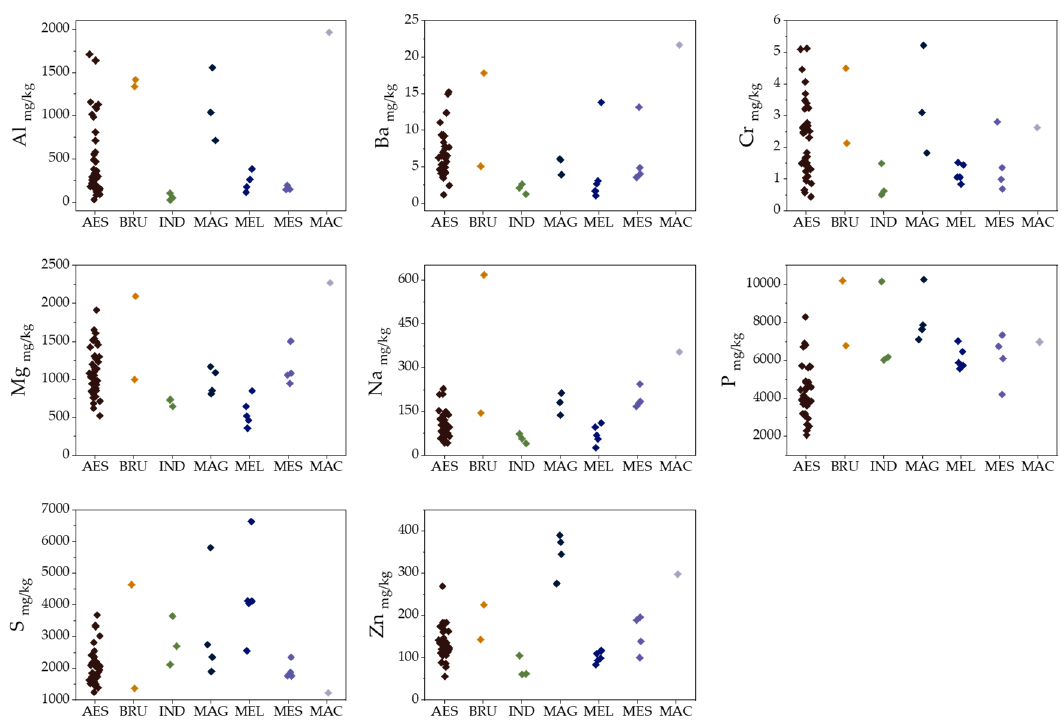
Figure 3. Column scatter plots of element contents in different truffle species: AES ( T. aestivum ), BRU ( T. brumale ), IND ( T. indicum ), MAG ( T. magnatum ), MEL ( T. melanosporum ), MES ( T. mesentericum ), and MAC ( T. macrosporum ).